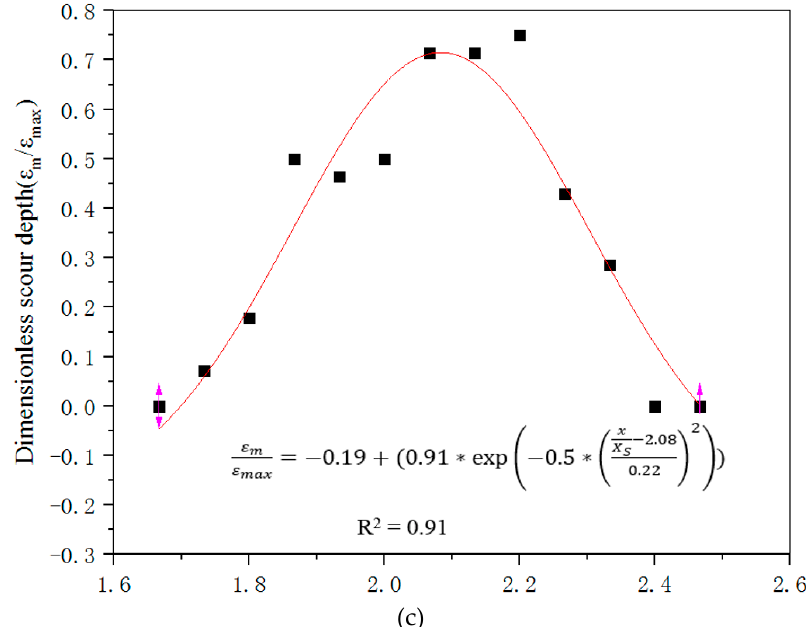
Figure 13. Dimensionless scour section of different zones for twin ‐ propeller. ( a ) Small scour hole ( − 0.5 < X/X m,twin < 0); ( b ) primary scour hole (0 < X/X m,twin < 1.6); ( c ) deposit mound (1.6 < X/X m,twin < 2.6).